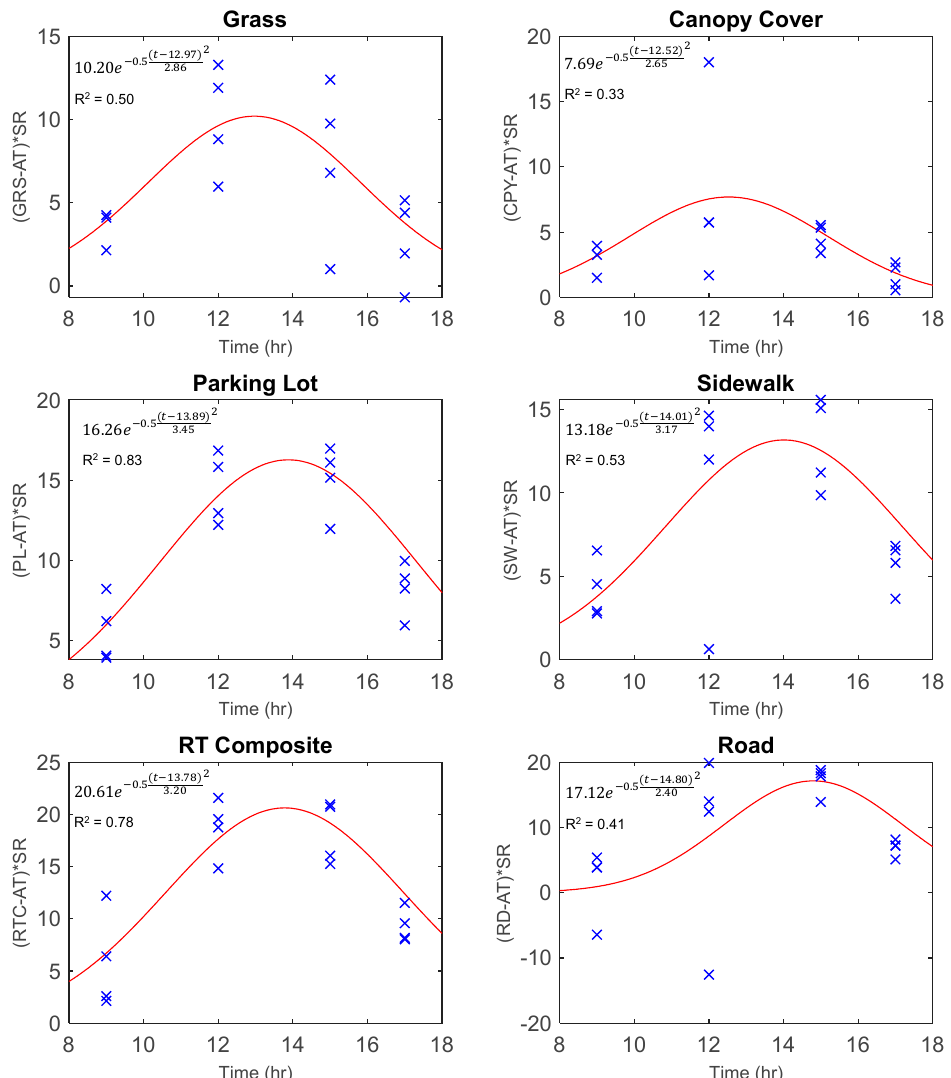
Figure 10. Gaussian peak models of six surface types: grass ( a ), canopy cover ( b ), parking lot ( c ), sidewalk ( d ), composite rooftop ( e ) and road ( f ). Note that GRS = grass; CPY = canopy; PL = parking lot; SW = sidewalk; RTC = composite rooftop; AT = air temperature; SR = solar radiation; t = time.